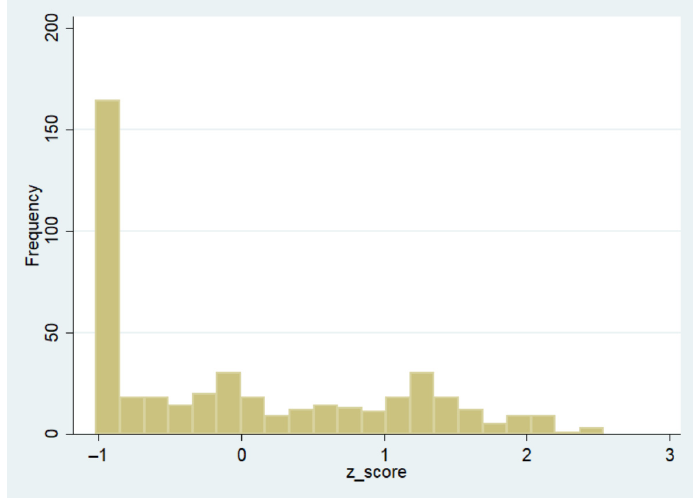
Figure 1. Histogram of financial literacy scores.